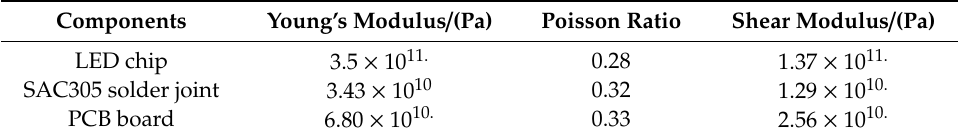
Table 5. Material properties of components used in the 3D